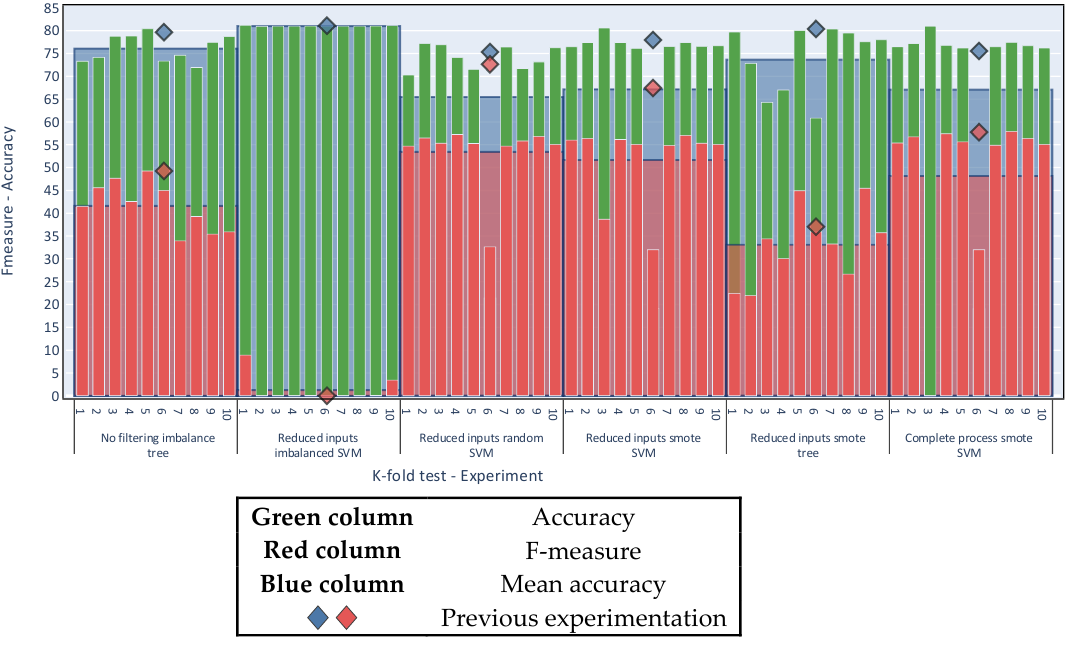
Figure 17. K-fold cross validation.